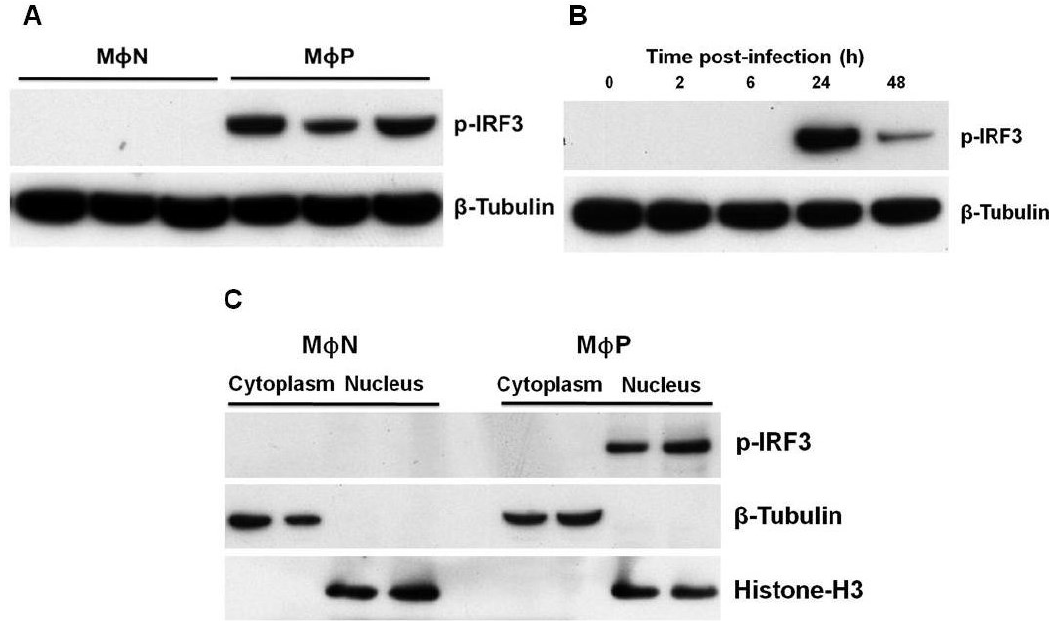
Figure 2. Phosphorylation and location of interferon regulatory factor 3 (IRF3) in persistently RSV-infected macrophages. ( A ) Phospho-IRF3 (p-IRF3) expression was analyzed by western blot in total cell lysates from passages 86, 90 and 93 of non-infected macrophages (MΦN) and from passages 85, 86 and 88 of persistently RSV-infected macrophages (MΦP); ( B ) As a positive control, induction of IRF3 phosphorylation was analyzed in acutely RSV-infected macrophages (m.o.i. of 2) at 2, 6, 24, and 48 h p.i. As loading control, the expression of β-tubulin was evaluated; ( C ) Cytoplasmic and nuclear subcellular fractions from passages 94 and 95 of MΦN and from passages 90 and 91 of MΦP were evaluated for localization of p-IRF3. To demonstrate the purity of the fractions, histone-H3 and β-tubulin (nuclear and cytoplasmic markers, respectively) were determined. Results were reproduced in six cellular passages analyzed (biological replicates).